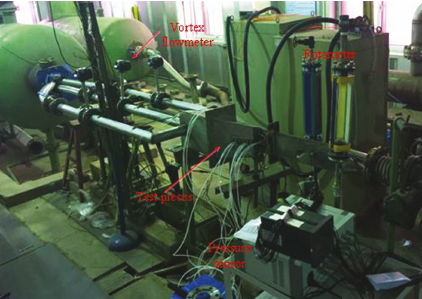
Figure 4: Experimental